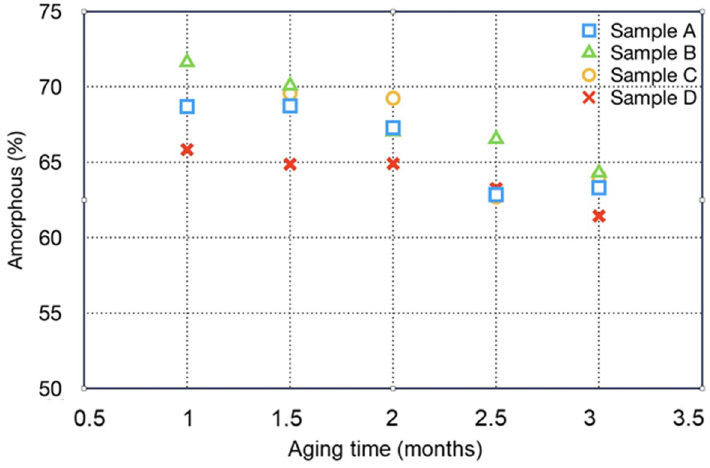
Figure 3. Amount of amorphous, evaluated by Rietveld method, as a function of samples aging time.